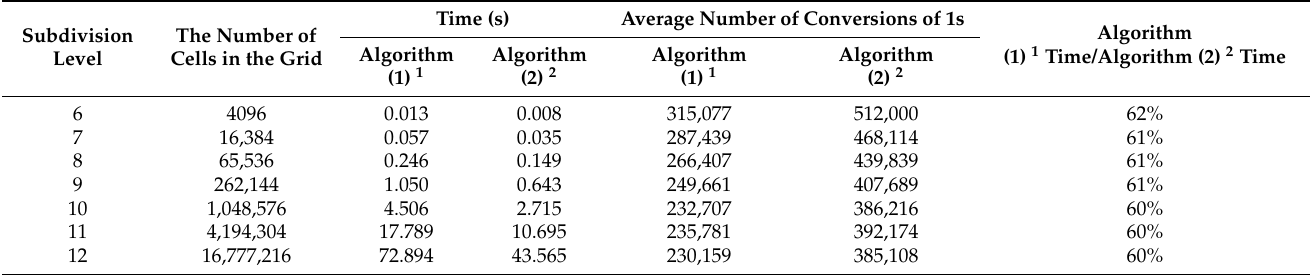
Table 5. Algorithmic efficiency of encoding conversion to row–column number.